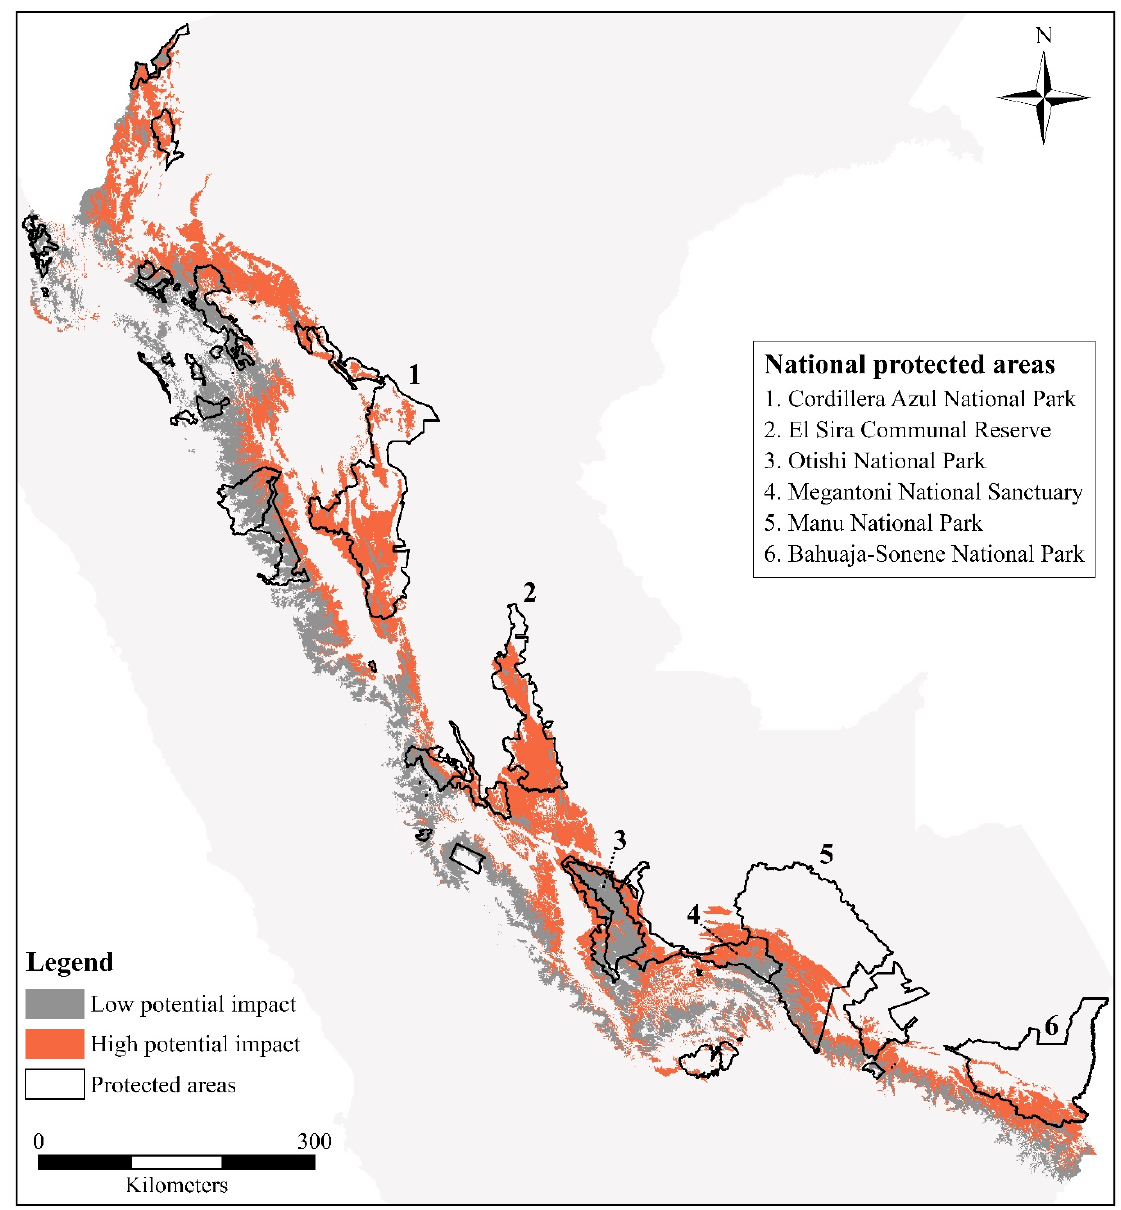
Figure 3. Potential climate change impact on Peruvian Andes forests in 2070, as a function of projected climate suitability. Projections were based upon a majority vote criterion, using the aggregated outcomes of 85 different models. Polygons in the figure indicate current national, regional and private protected areas. Numbers in the figure correspond to six national protected areas that in conjunction contain 62% of all currently protected montane forests in Peru.